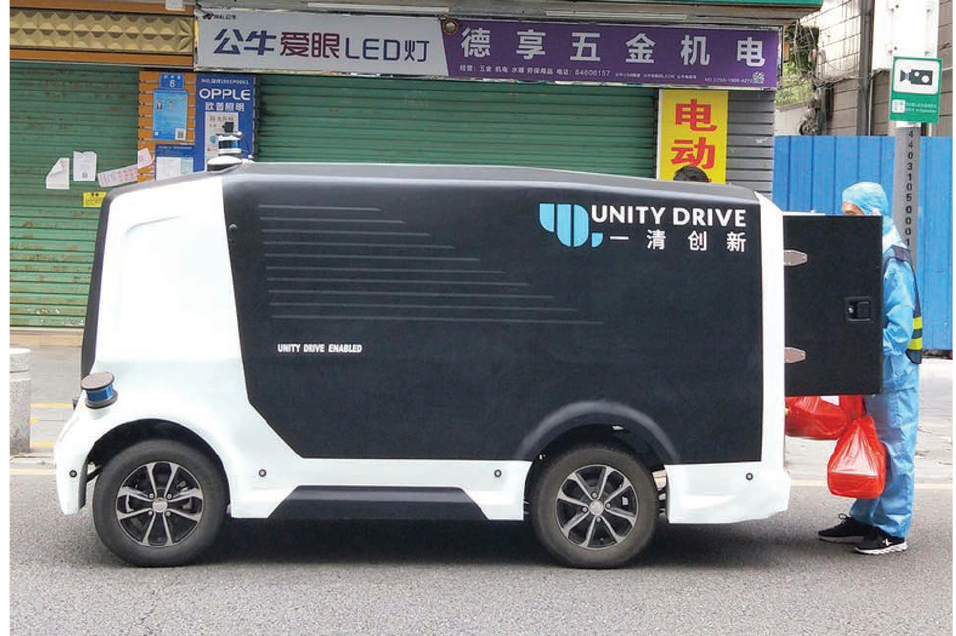
Figure 3. Hercules logistic AV used during COVID-19 pandemic to deliver goods [12].